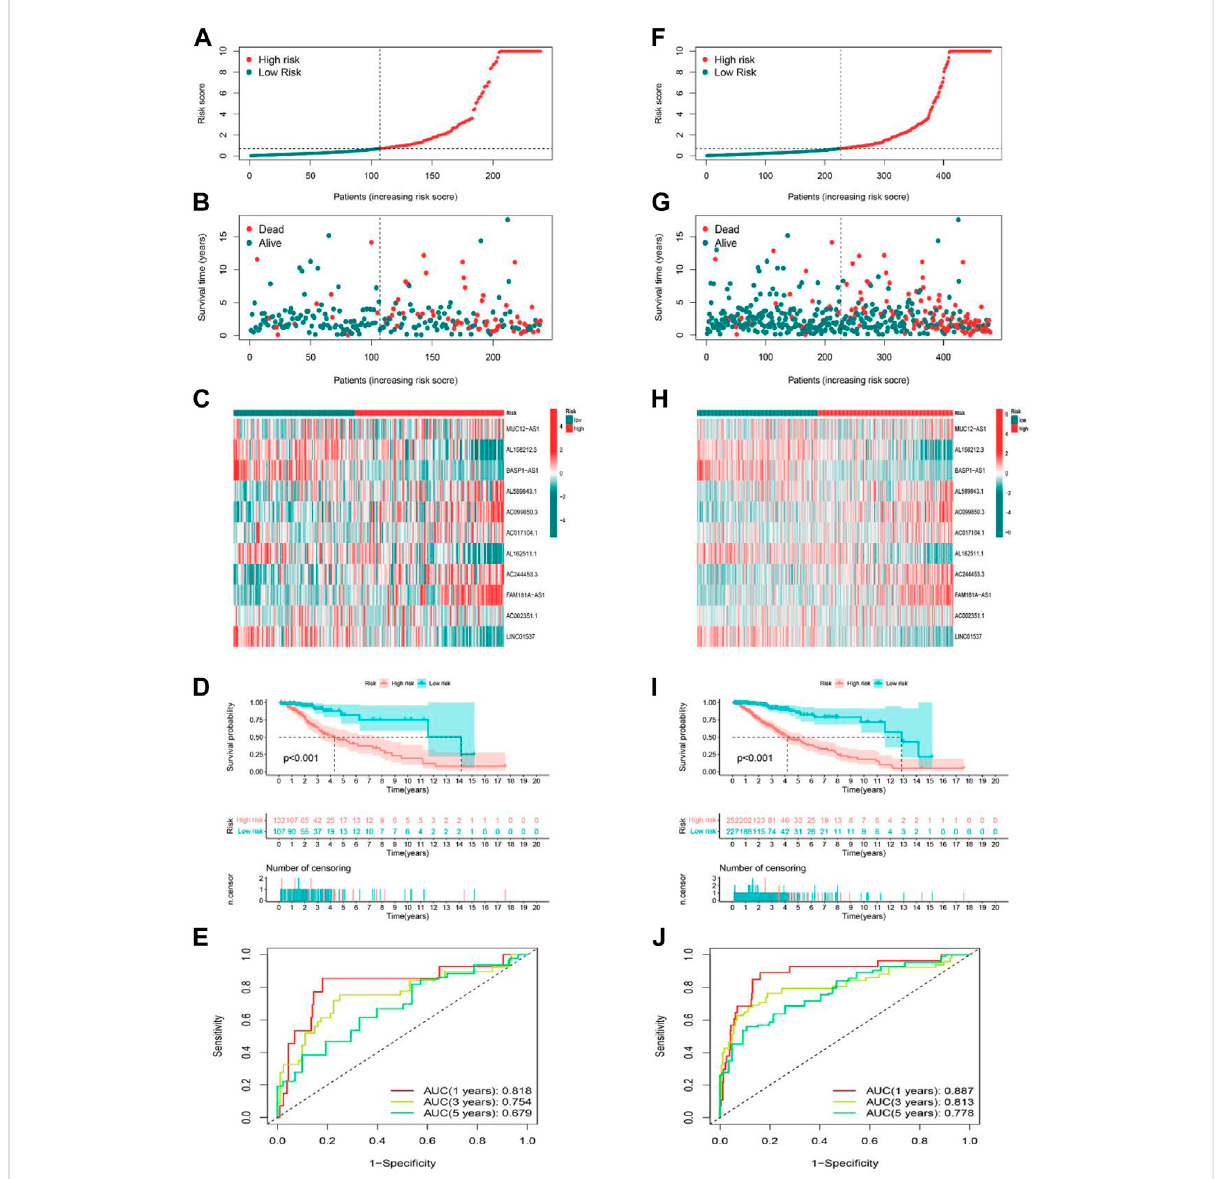
groups in the testing set. (E) The AUCs of testing are set for 1-, 3-, and 5-year OS rates. (F – H) The distributions of the risk scores, survival status, and the expression heatmap for 11 hub lncRNAs in the entire set. (I) Kaplan-Meier survival curves of the OS of patients in the high-risk and low-risk groups in the entire set. (J) The AUCs of the entire set for 1-, 3-, and 5-year OS